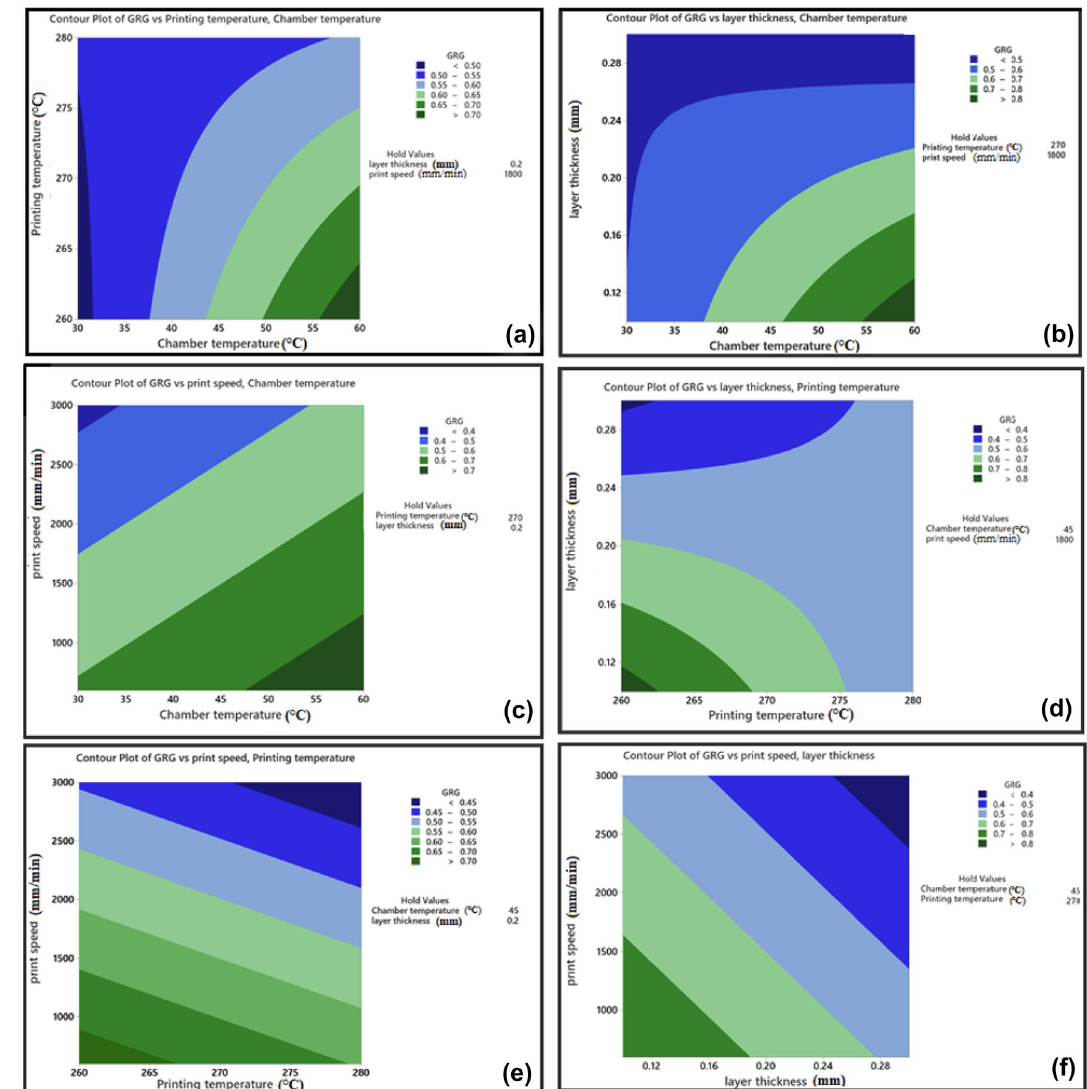
Figure 11. GRG contour plots. The effect of; ( a ) chamber temperature and printing temperature, ( b ) chamber temperature and layer thickness, ( c ) chamber temperature and print speed, ( d ) printing temperature and layer thickness, ( e ) printing temperature and print speed, ( f ) layer thickness and print speed, on GRG.